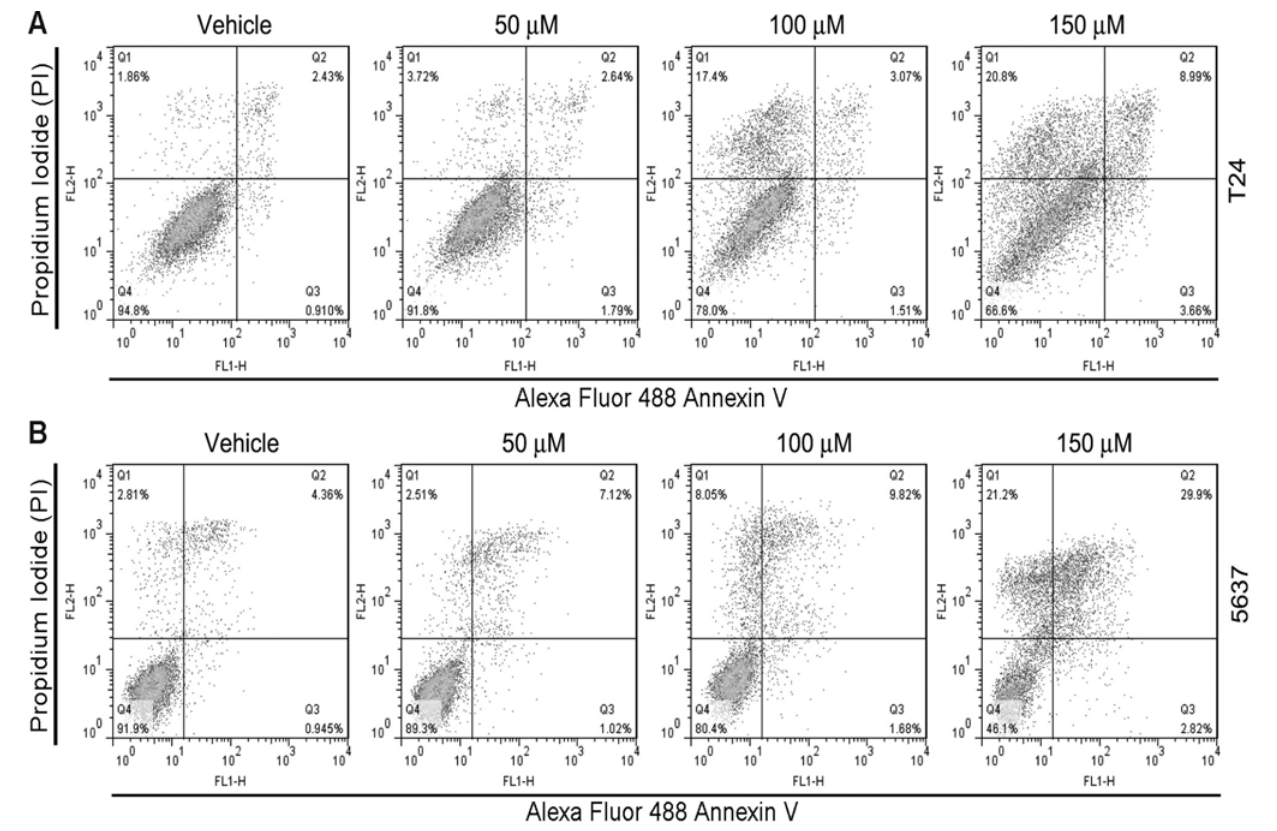
Fig 3. δ -T3 induces apoptosis in bladder cancer cells. Annexin V/PI analysis showed that δ T3 induced apoptosis in T24 (A) and 5637 (B) bladder cancer cells, as compared to vehicle treated control cells.